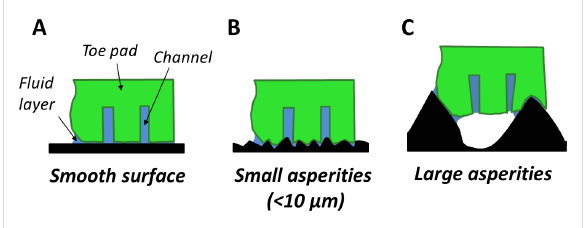
Figure 8: Simplified diagram predicting toe pad contact on different rough surfaces. Contact on a smooth surface (A) is shown, along with the pads conformity to rough surfaces with small (B) and large asperities (C).